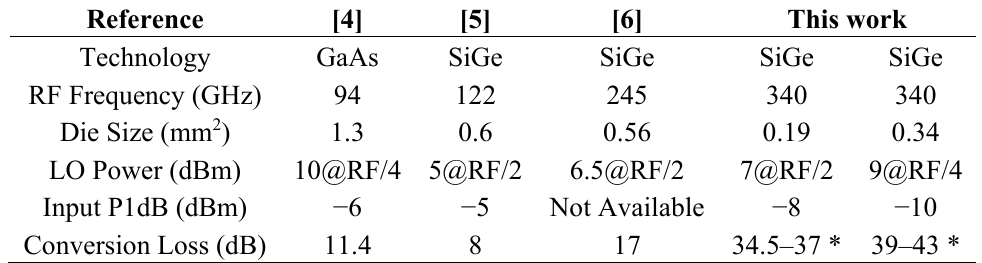
Table 1. Performance comparison of anti-parallel-diode-pair (APDP)-based